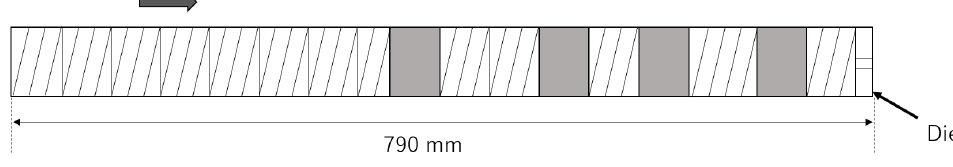
Figure 11. Screw configuration of experiment 2. The arrow indicates the direction of flow.